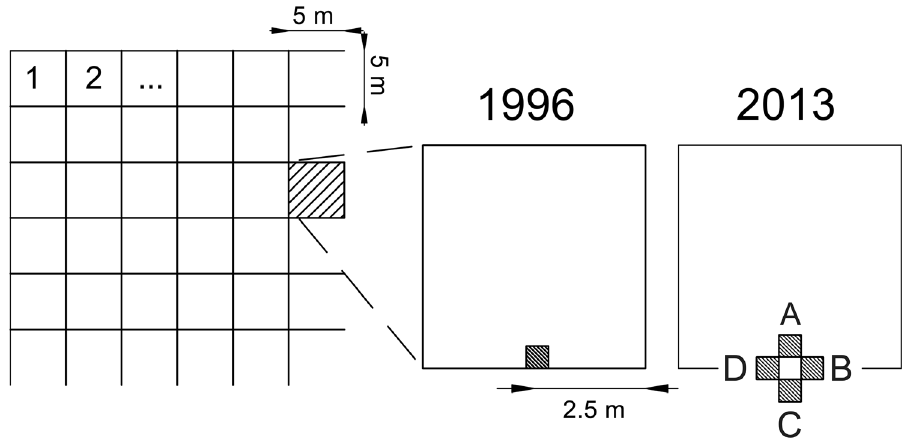
Figure 1. Design of the sampling methods. In each cell of a 5 m × 5 m grid a 0.25 m² plot was sampled in 1996. Blocks of four 0.25 m² plots were resampled in the same grid in